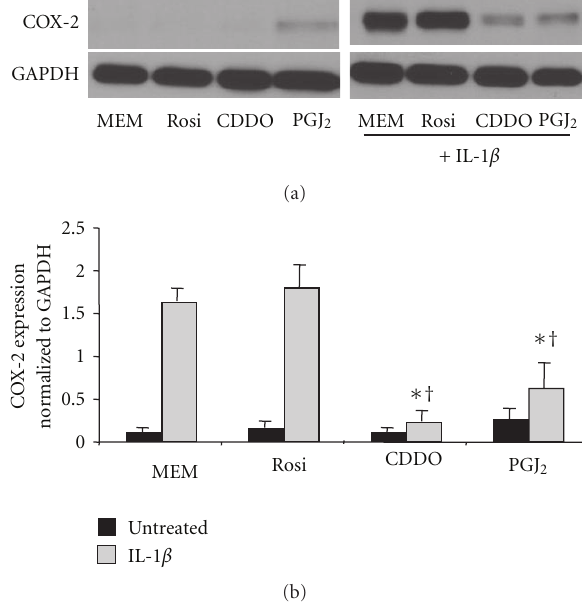
Figure 3: CDDO and 15d-PGJ 2 attenuate IL-1 β -induced COX- 2 production in human lung fibroblasts. Primary human lung fibroblasts were pretreated with 20 μ M rosiglitazone (Rosi), 1 μ M CDDO, or 5 μ M 15d-PGJ 2 (PGJ 2 ) for 1 hour and then cotreated with 1ng/mL of IL-1 β for 24 hours. Protein lysates were har- vested and Western blot analysis was performed by probing for protein expression of COX-2 and GAPDH (for normalization). (a) Representative samples are shown. (b) Quadruplicate samples were analyzed by densitometry and normalized to GAPDH. COX- 2 expression was significantly reduced in CDDO and 15d-PGJ 2 treated cells compared to IL-1 β alone ( ∗ P < . 001). CDDO and 15d- PGJ 2 were significantly more potent than rosiglitazone ( † P < . 001). Results are mean ± standard deviation for quadruplicate wells and are representative of 3 independent experiments that yielded similar results. Data were analyzed by